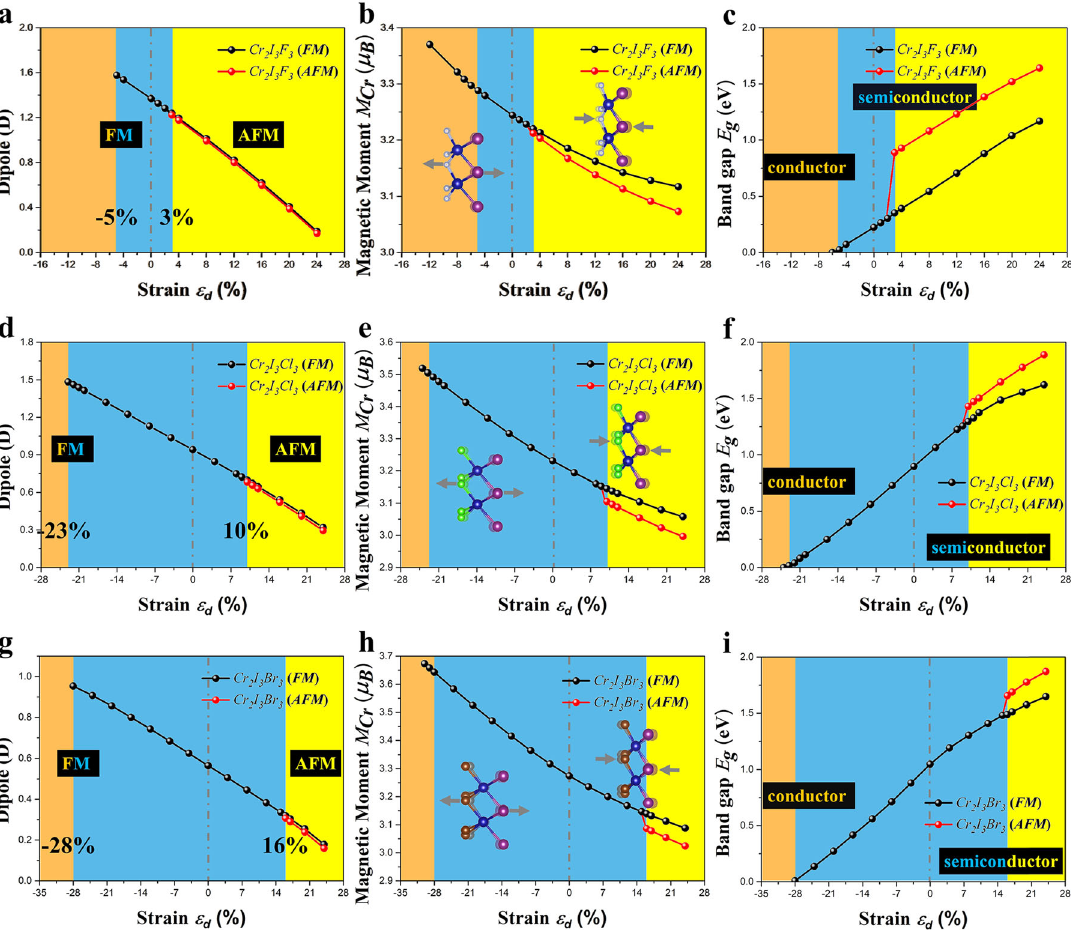
Fig. 7 Vertical strain effects. The EP dipole moment with respect to vertical spacing variation ε d for ( a ) Cr 2 I 3 F 3 , ( d ) Cr 2 I 3 Cl 3 , and ( g ) Cr 2 I 3 Br 3 . The Magnetic moments per Cr atom with respect to vertical spacing variation ε d for ( b ) Cr 2 I 3 F 3 , ( e ) Cr 2 I 3 Cl 3 , and ( h ) Cr 2 I 3 Br 3 . The band gaps concerning vertical spacing variation ε d for ( c ) Cr 2 I 3 F 3 , ( f ) Cr 2 I 3 Cl 3 , and ( i ) Cr 2 I 3 Br 3 . The transitions between different phases are labeled differently, e.g., orange, blue, and yellow blocks indicate FM conductor, FM semiconductor, and AFM semiconductor phases,